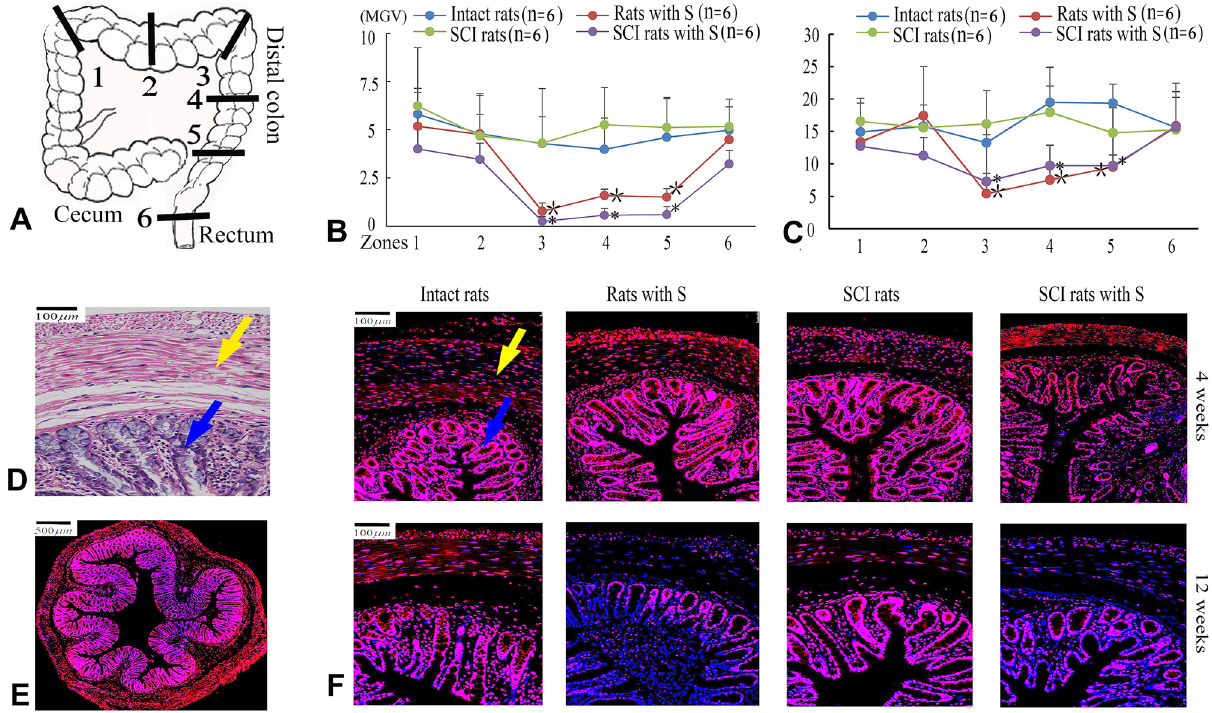
Figure 5. Distribution of Alpha-2 adrenergic receptor in colon. ( A ) The excised sections were showed by zones. ( B , C ) The mean grayscale value (MGV) of Alpha-2 adrenergic receptors in colonic smooth muscle layer ( B ) and colonic mucosa layer ( C ) 12 weeks after PSIMA. *SCI rats with S versus SCI rats, † Rats with S versus Intact rats in Zone 3, 4, 5, P < 0 ⋅ 05 (two-way ANOVA). ( D ) Colonic tissue (TRI staining), the smooth muscle tissues are directed by the yellow arrows, and the colonic mucosa tissue by the blue arrows. ( E , F ) Representative fluorescent images of Alpha-2 adrenergic receptors (red) in colonic tissue, cross-sectional anatomy of colon ( E ), and high-power images ( F